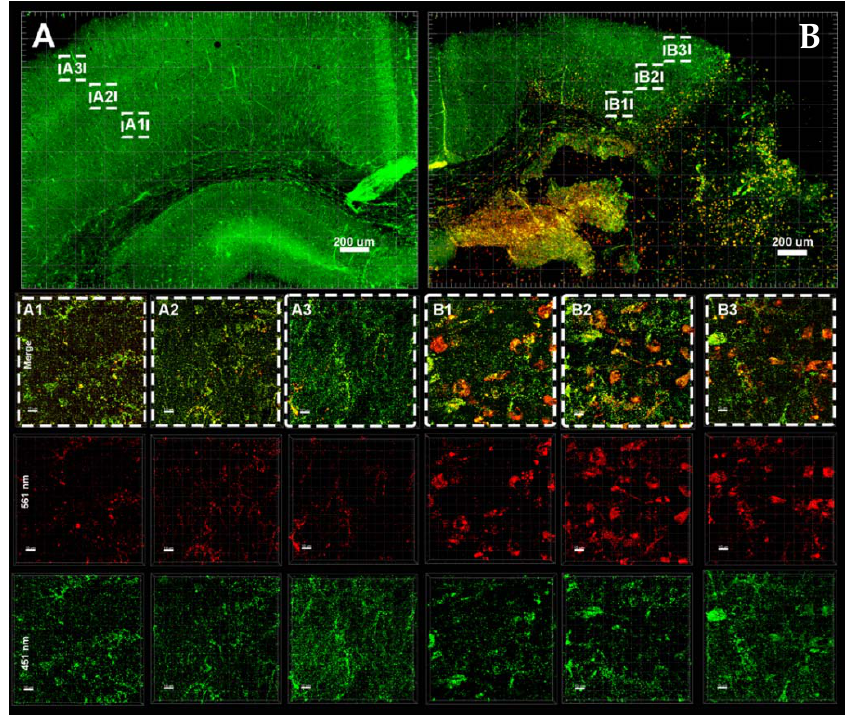
Figure 5. Assessment of mitophagy 24 h after HI in the brain tissue of mt ‐ Keima mice by super ‐ resolution microscopy. ( A1 – A3 ): Injured hemisphere, ( B1 – B3 ) uninjured hemisphere; serial sections are visualized at 100 μ m intervals of both hemispheres. ( A1 – B3 ): Merge, red channel: excitation at 561 nm, green channel: excitation of 458 nm.